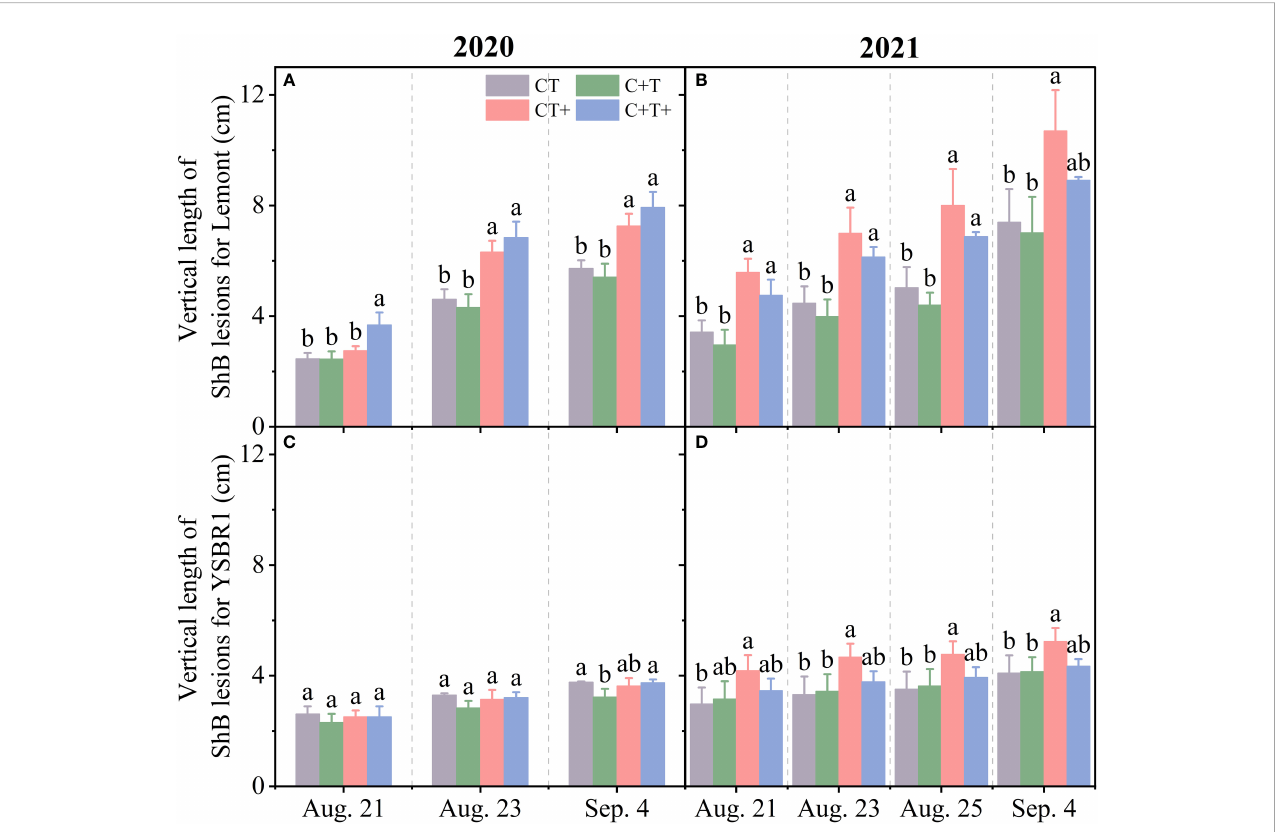
FIGURE 2 The vertical length of ShB lesions for inoculated plants of cvs Lemont (A, B) and YSBR1 (C, D) under ambient condition (CT), elevated CO 2 (C+T), elevated temperature (CT+) and the combination of elevated CO 2 and elevated temperature (C+T+) in the T-FACE experiments of 2020 and 2021. Each data represents the mean value of three replications (with bars for ± standard errors of the mean). Different letters above the bars in the same time of each parameter indicate statistically signi fi cant differences ( p <